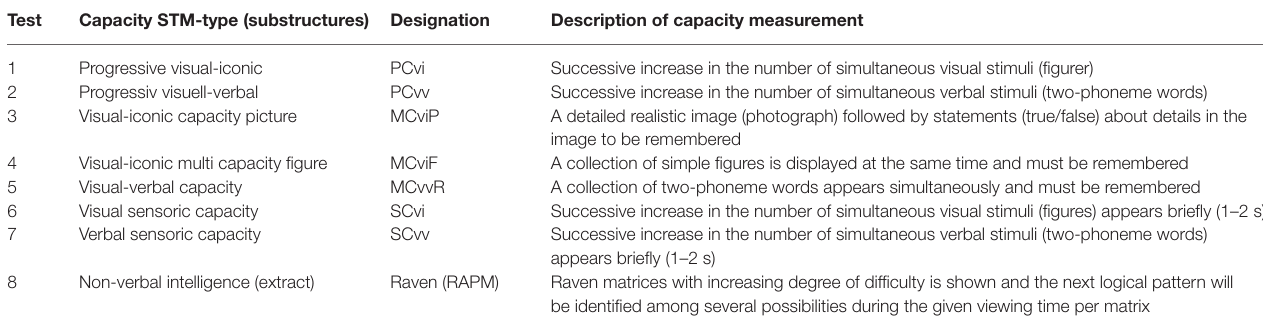
TABLE 3 | Overview of the sub-tests (capacity STM-types/substructures) included in the STM capacity measurement